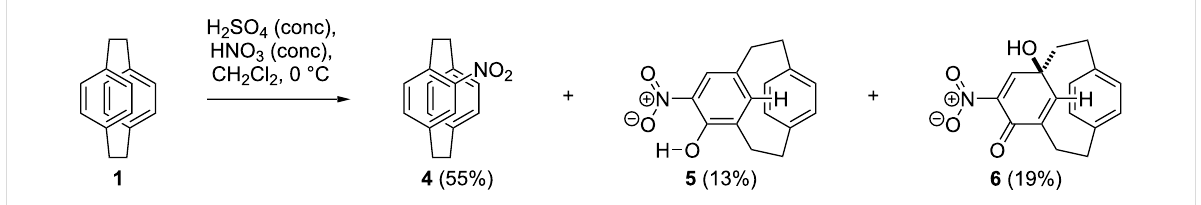
Scheme 1: Nitration of [2.2]paracyclophane ( 1 ) and the synthesis of 4-hydroxy-5-nitro[2.2]metaparacyclophane ( 5 ) and the cyclohexadienone cyclo- phane 6 (average yield from more than three repeats quoted).